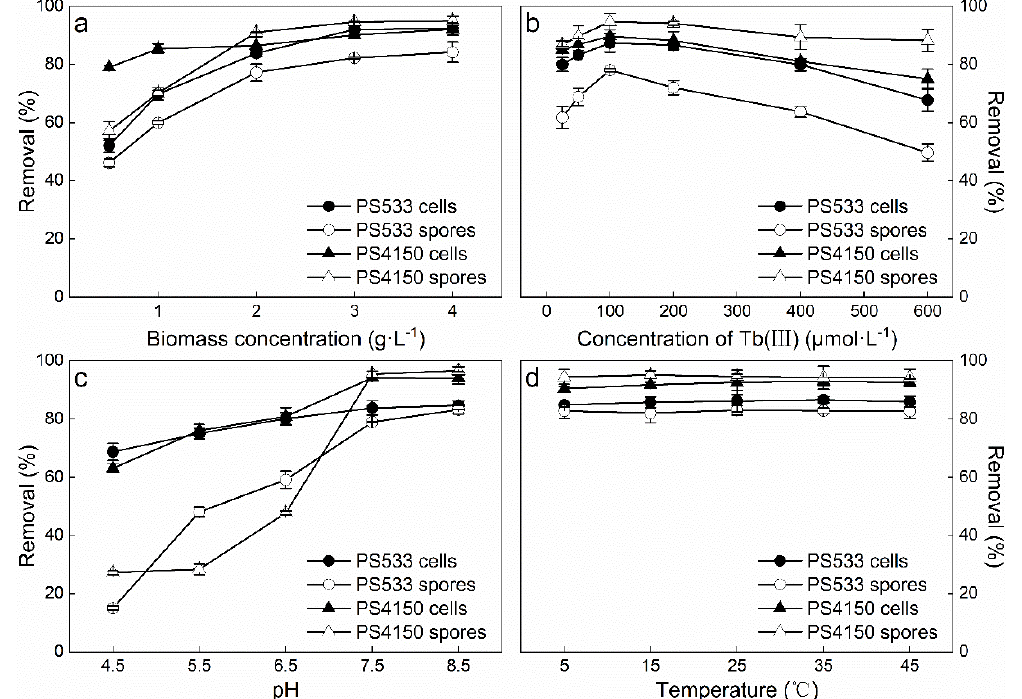
Figure 1. Tb(III )− removal by B. subtilis PS533/PS4150 cells and spores under different conditions: ( a ) biomass concentration (0.5~3 g·L −1 ), ( b ) initial concentration of Tb(III) (25~600 µmol·L −1 ), ( c ) pH ( a ) biomass concentration (0.5~3 g · L − 1 ), ( b ) initial concentration of Tb(III) (25~600 µ mol · L − 1 ), ( c ) pH (4.5~8.5), and ( d ) temperature (5~45 °C). (4.5~8.5), and ( d ) temperature (5~45 ◦